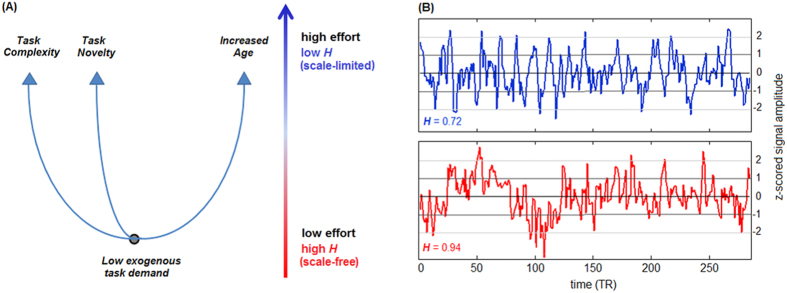
Plots depicting (A) the central hypothesis of the paper, and (B) fractal scaling examples in fMRI. (A) schematic illustrating the key hypothesis of this paper: effort is inversely related to fractal scaling. For low task effort, the brain is in a highly scale-free “ground” state (depicted by the black disk). Numerous factors increase cognitive effort (and decrease H), including task complexity, task novelty, and aging. This is analogous to the “potential energy wells” that are often employed in physics diagrams. (B) BOLD timecourse for two subjects from the Verbal Working Memory Task (VWMT), based on an 8-voxel seed in the posterior cingulate, with Hurst exponents of H = 0.72 (moderately fractal) and H = 0.94 (highly fractal). We observe smooth, highly autocorrelated time-series for the more fractal red curve.